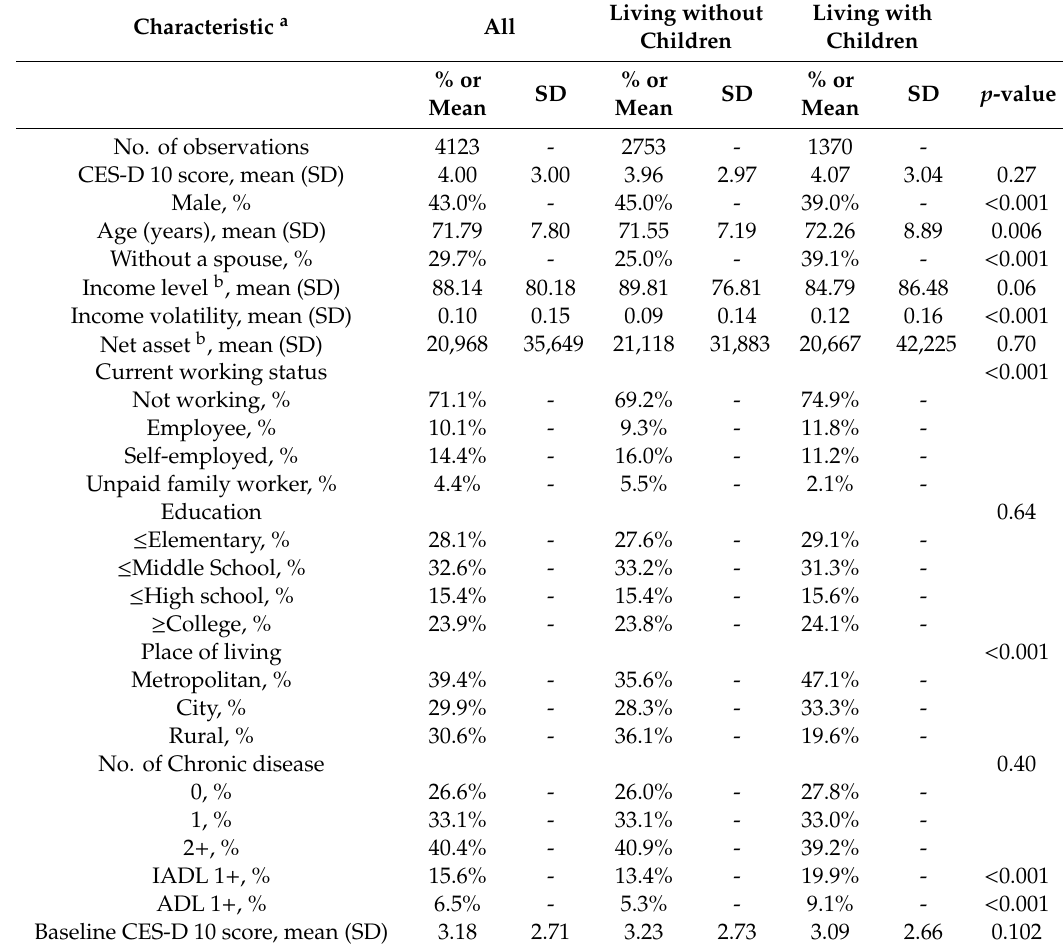
Table 1. General characteristics of study